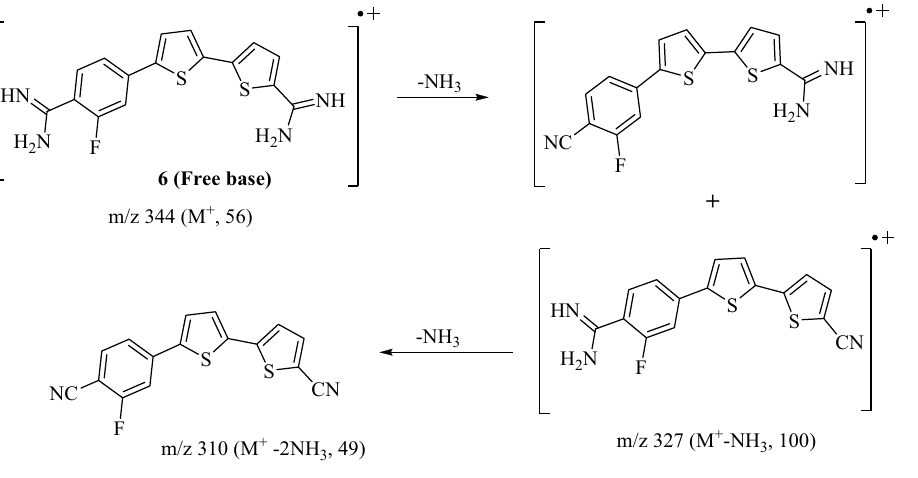
Figure 3. Mass fragmentation pattern of bithienylbenzamidine derivative 6